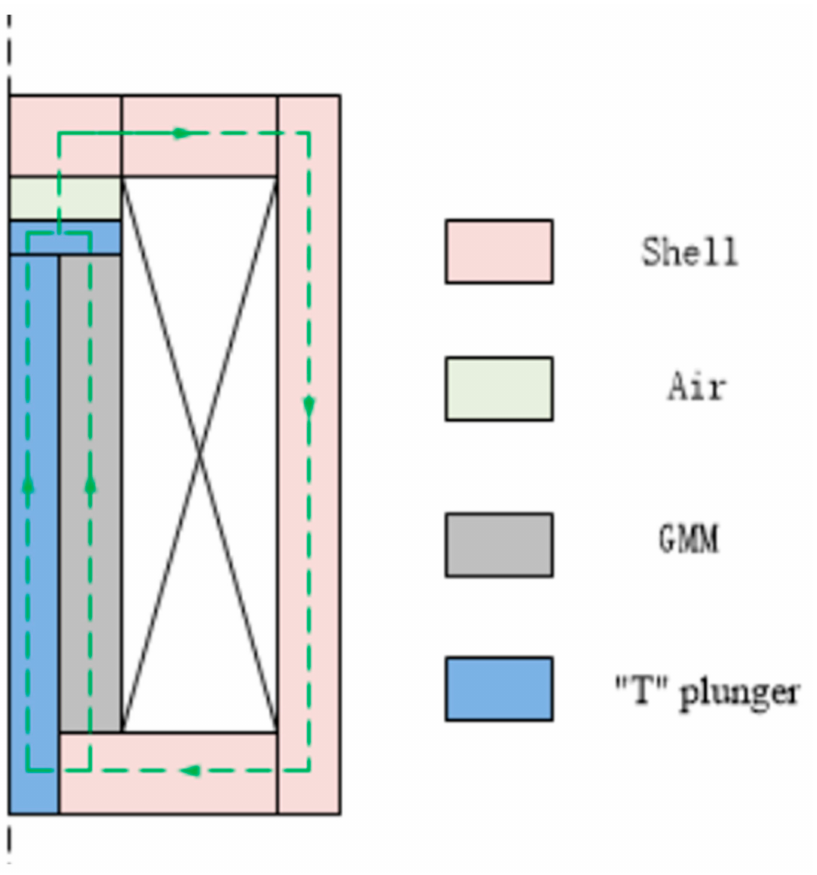
Figure 3. Schematic diagram of GMA magnetic